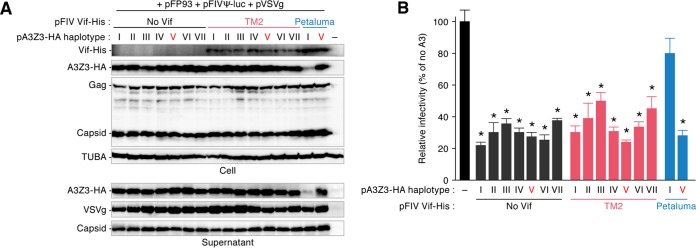
Effect of FIV Vif against feline A3Z3 haplotypes. The expression plasmids for His-tagged Vif of FIV TM2 or FIV Petaluma were cotransfected with or without the expression plasmids for a series of feline A3Z3 haplotypes tagged with HA. Representative results of Western blotting assays (A) and FIV reporter assays (B) are shown. * in panel B, P < 0.05 versus no A3Z3. The assays were independently performed in triplicate. The data represent averages with SDs. Note that the feline A3Z3 used in the other experiments is haplotype I.